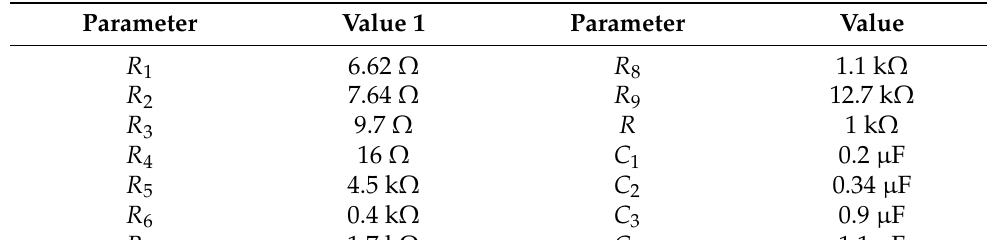
Table 4. Component values for the electronic diagram of the controller in Figure 6 for the experimental implementation of partial fractional expansion (19).